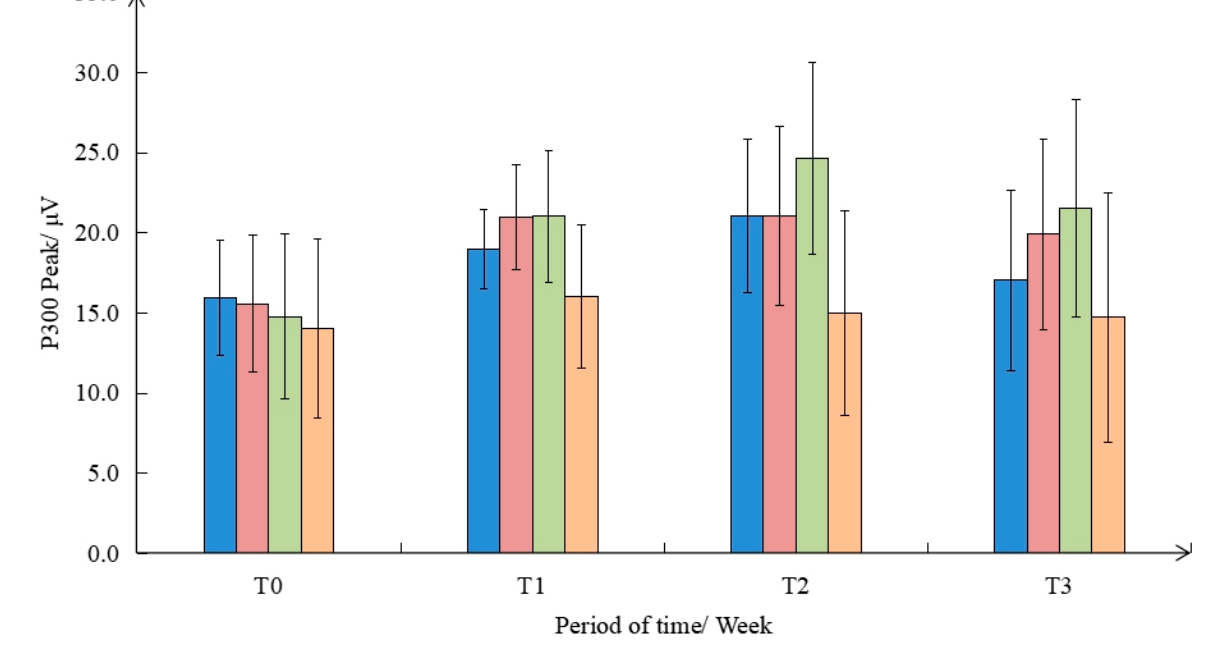
Int. J. Environ. Res. Public Health 2022 , 19 , 8567 11 of 17